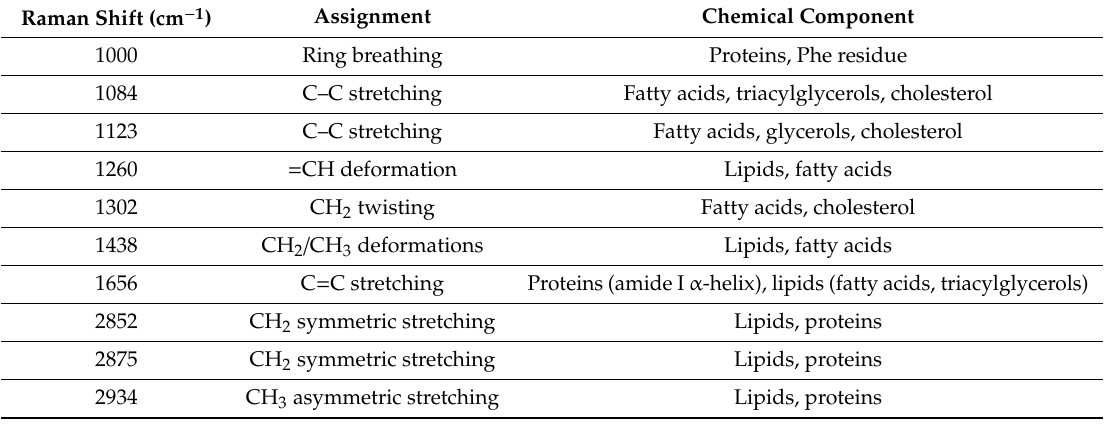
Table 3. Assignment of the vibrational bands in Raman spectra of synovial fluid accumulated as pellet deposition in the ten-year-old retrieved prosthetic (Figure 7C,D).